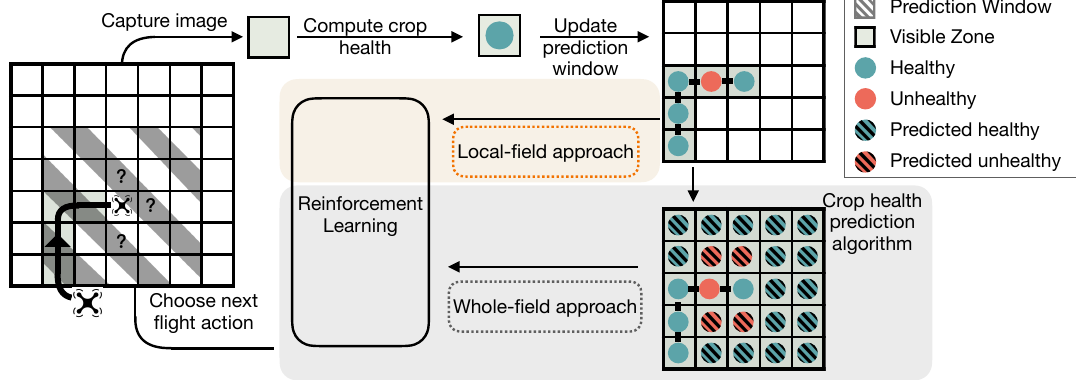
Figure 2. Difference between whole-field and local-field